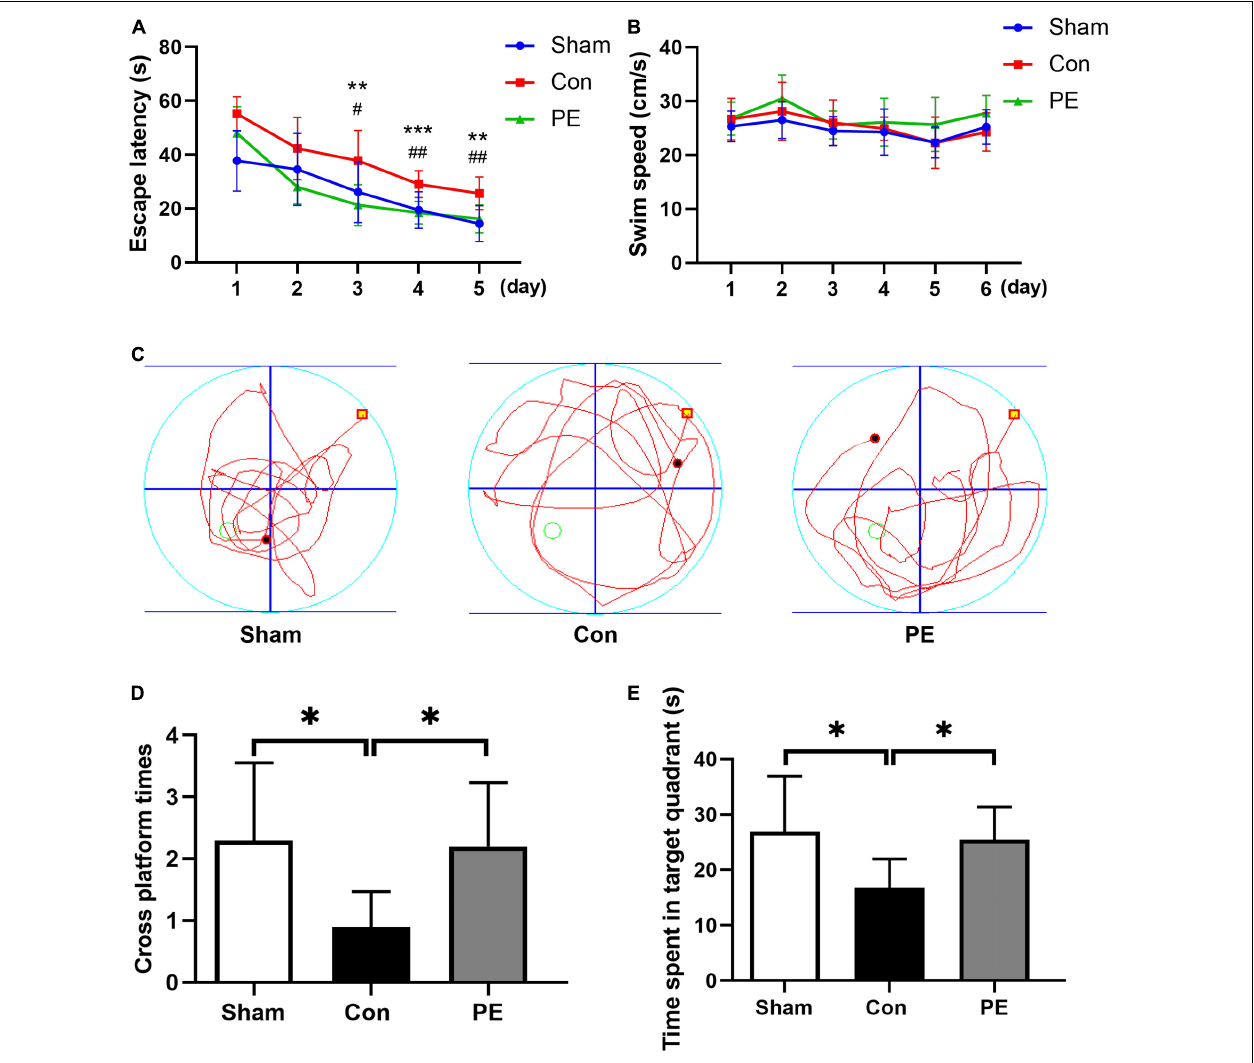
FIGURE 2 | Physical exercise improved spatial memory in rats with chronic cerebral hypoperfusion. In the place navigation test: (A) the escape latency of rats in each group. PE vs. Con: ** P < 0.01, *** P < 0.001; Sham vs. Con: # P < 0.05, ## P < 0.01. (B) The swimming speed of rats in each group. There was significant difference in the escape latency ( P < 0.001) but not the swimming speed ( P > 0.05) between the different groups in the overall. In the spatial probe test: (C) Representative swimming trajectories of rats in each group. (D) Times of crossing the target platform of rats in each group. (E) Time spent in the target quadrant of rats in each group. n = 10. Experimental data are expressed as the means ± SD. ∗ P < 0.05, ∗∗ P < 0.01. Con, control; PE, physical